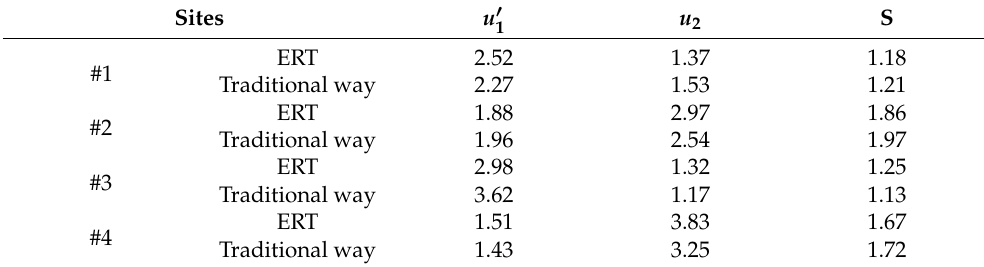
Figure 8. The calculated BTCs by using the traditional method and ERT respectively. (The blue square represents the data obtained by traditional methods, and the orange triangle represents the data obtained by ERT, #1–#4 represents four different conceptual areas respectively). Table 3. Calculation results of time moments for BTCs obtained by different methods.